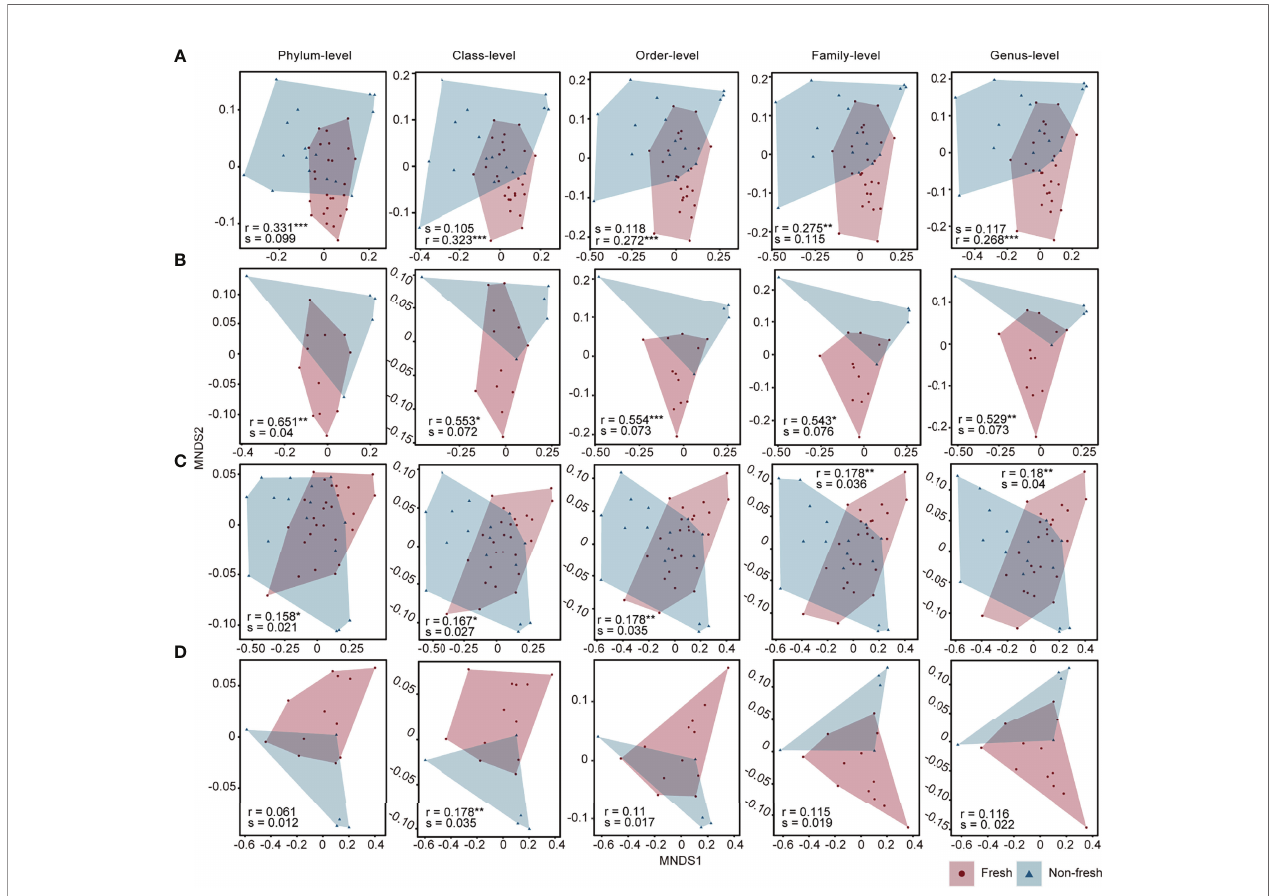
FIGURE 6 | NMDS ordination of samples in two groups based on Bray-Curtis distance at different taxonomic levels. In form of the bacterial relative abundance, samples shown in (A) represents all 42 sites while (B) only represents samples with BIX < 0.8 or BIX > 1.2. In form of the bacterial abundance, samples shown in (C) represents all 42 sites while (D) only represents samples with BIX < 0.8 or BIX > 1.2. Red circles indicate sites of the Group F while blue triangles indicate sites of the Group N. Signi fi cance of difference between two groups based on NMDS was tested via ANOSIM. Signi fi cance labels: ***p < 0.001, **p < 0.01, *p <